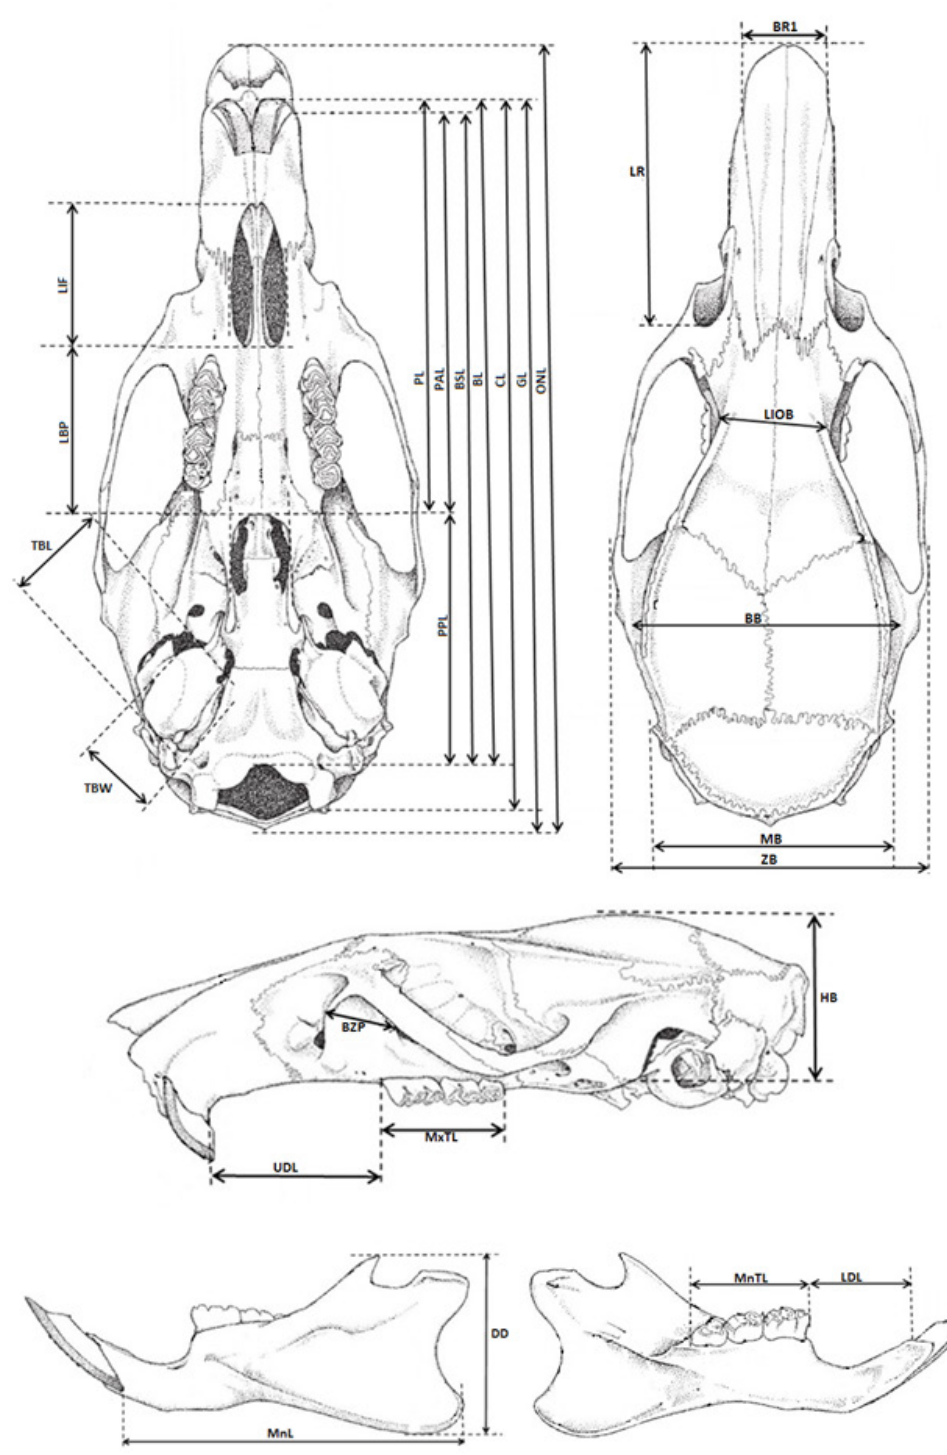
Figure 2: Dorsal, ventral and lateral views of cranium of a murine rodent (and mandible in the latter case), illustrating measurements taken in this study (refer Table 4 for abbreviations). (Figure modified from Musser et al ., 2006; measurements from Buttler and Greenwood, 1979; Musser et al ., 2006; Meegaskumbura et al .,